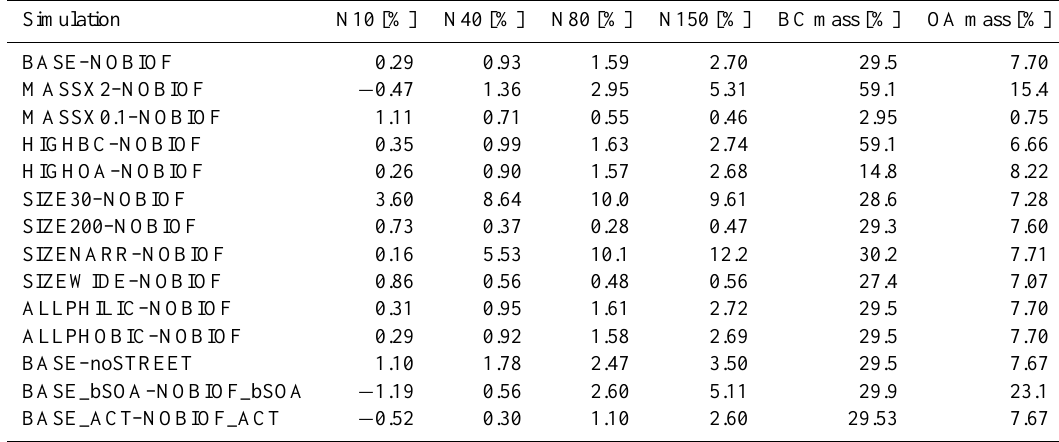
Table 3. Global, annual-mean percent change in the boundary layer in N10, N40, N80, N150, mass of BC, and mass of OA for the compar- isons